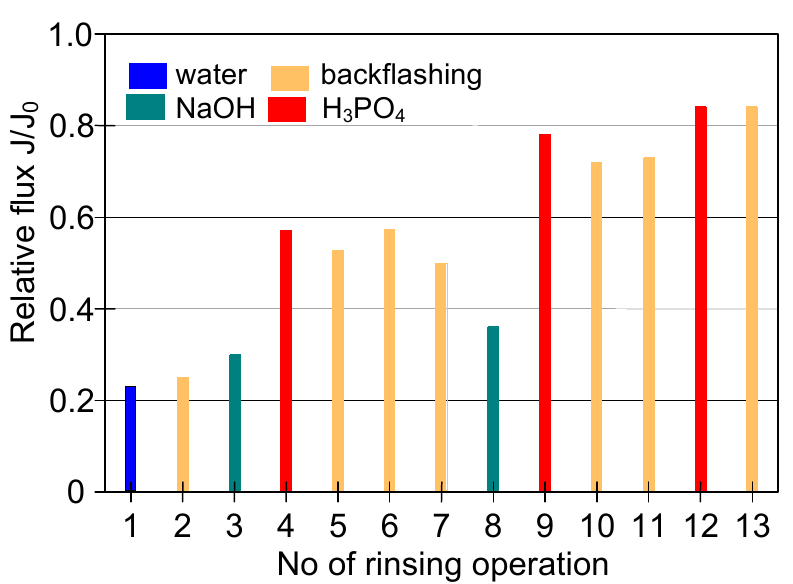
Figure 16. The efficiency of cleaning the ceramic membrane after the MF (TMP = 0.08 MPa, V F = 5.5 m/s) of 1,3-PD fermentation broth with Lactobacillus casei . Operation time: water—30 min, backwash—5 min, NaOH—60 min, acid—60 min.